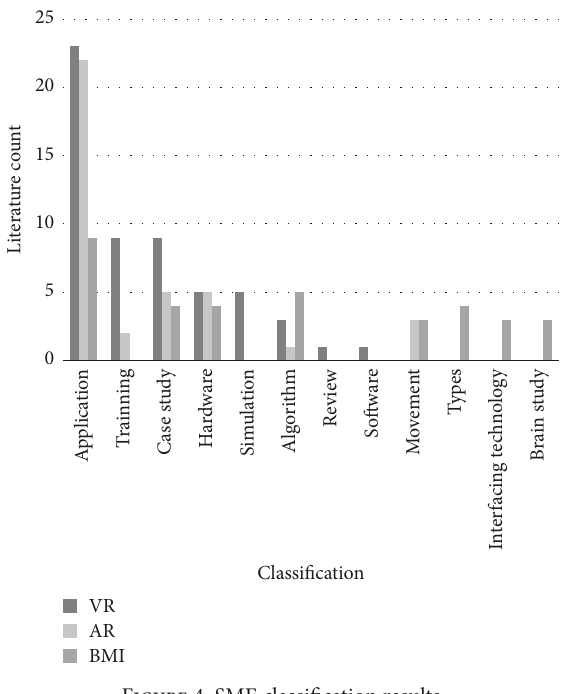
Figure 4: SME classification results. Table 2: Publication counts by categories (indicating R&D trends and